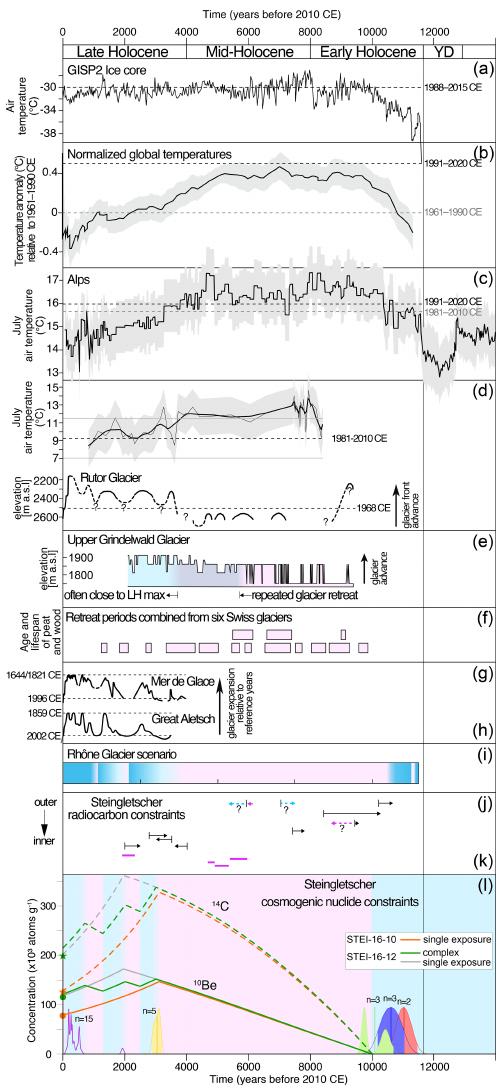
Figure 7. Holocene advance and retreat history of Steingletscher (l) in comparison with independent records. (a) Greenland sum- mit temperatures (Kobashi et al., 2017). (b) Global temperature anomalies relative to 1961–1990CE (Marcott et al., 2013). The black dashed line is the global annual mean temperature anomaly in 1991–2020CE (https://data.giss.nasa.gov/gistemp/, last access: 10 Jan- uary 2022). (c) Chironomid-based stacked summer temperature at 1000ma . s . l . (Heiri et al., 2015). The dashed lines are the modern July temperatures at the weather stations closest to Hinterburgsee and Stazersee, i.e. Meiringen (588ma . s . l . ) and Samedan (1708ma . s . l . ) (https://www.meteoswiss.admin.ch, last access: 10 January 2022), extrapolated to 1000ma . s . l . , using a lapse rate of 6 ◦ C / 1km as in Heiri et al. (2015). (d) Pollen-inferred summer temperatures from the Rutor Glacier forefield (Italian Alps), modern July temperature and un- certainty as horizontal lines. Fluctuations of Rutor glacier in comparison to 1968CE (Badino et al., 2018). (e) Speleothem-based ele- vation changes of Upper Grindelwald Glacier (central Swiss Alps) (Luetscher et al., 2011). (f) Recession periods of six Swiss glaciers based on radiocarbon-dated subfossil wood and peat (Joerin et al., 2006). (g, h) Glacier fluctuations of Great Aletsch (central Swiss Alps; length changes) and Mer de Glace (northern French Alps; altitude changes) based on radiocarbon-dating and dendrochronology (Holzhauser et al., 2005; Le Roy et al., 2015, respectively). The grey extension added to the curve of Great Aletsch is the loss in length until 2020CE (http://www.glamos.ch/en/factsheet#/B36-26, last access: 10 January 2022). (i) Holocene advance and retreat scenario of Rhône Glacier, central Swiss Alps (Goehring et al., 2011). (j) Bracketing radiocarbon ages from Steingletscher forefield (King, 1974) with arrow lengths corresponding to the 2 σ age intervals. Plain arrows stand for moraine deposits or glacier advances. Dashed arrows correspond to pollen- inferred climate cooling (blue) or warming (pink) trends. (k) Radiocarbon dates of organic samples melted out from Steingletscher and Steinlimigletscher, with line lengths corresponding to the 2 σ age intervals (Hormes et al., 2006). (l) Steingletscher advance and retreat sce- nario (this study). Summed probability curves are mean 10 Be moraine ages (Schimmelpfennig et al., 2014). The modeled in situ 14 C and 10 Be concentrations are trajectories at the bedrock surface (Eulerian perspective). Blue bands are periods dominated by glacier positions larger than in ∼ 2000CE; pink bands are periods with dominantly smaller glacier extents. https://doi.org/10.5194/cp-18-23-2022 Clim. Past, 18, 23–44,